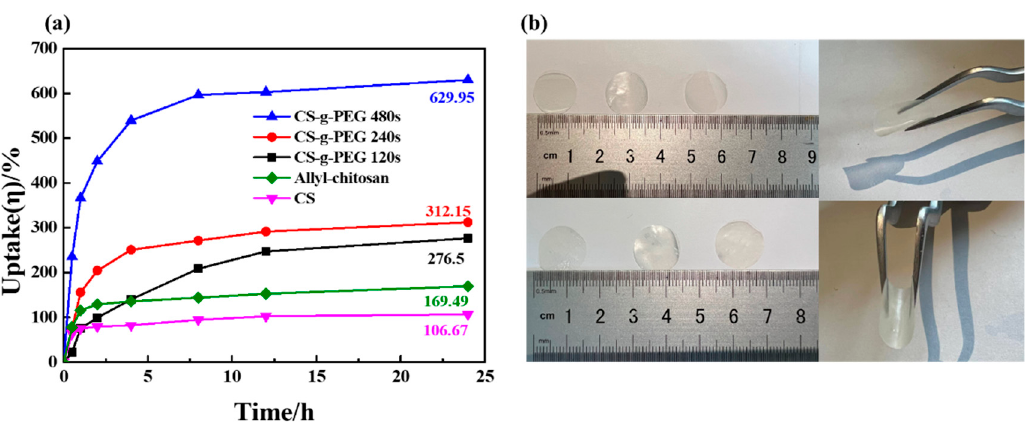
Figure 4. ( a ) Swelling properties of chitosan, allyl-chitosan and CS-g-PEG 120, 240 and 480 films after 24 h immersion in electrolytes. ( b ) Photographs of the films before and after swelling in liquid electrolyte.